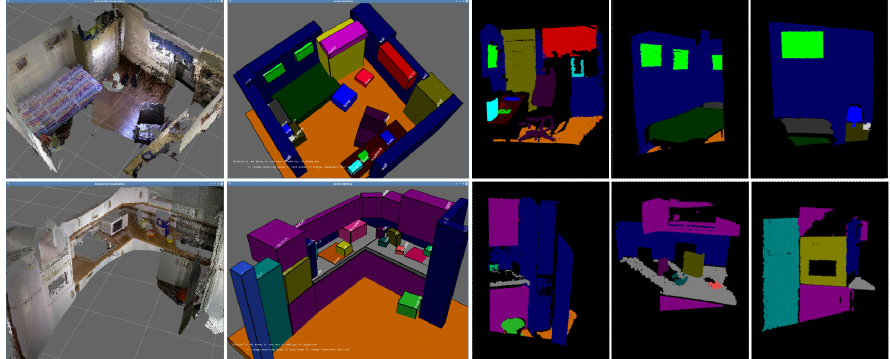
Figure 8. Examples of information from the Robot@Home dataset. The first column presents reconstructed scenes from the sequences within the dataset. The second column shows labeled reconstructed scenes. The third to fifth columns are examples of individual point clouds from RGB-D observations labeled by the propagation of the annotations within the reconstructed